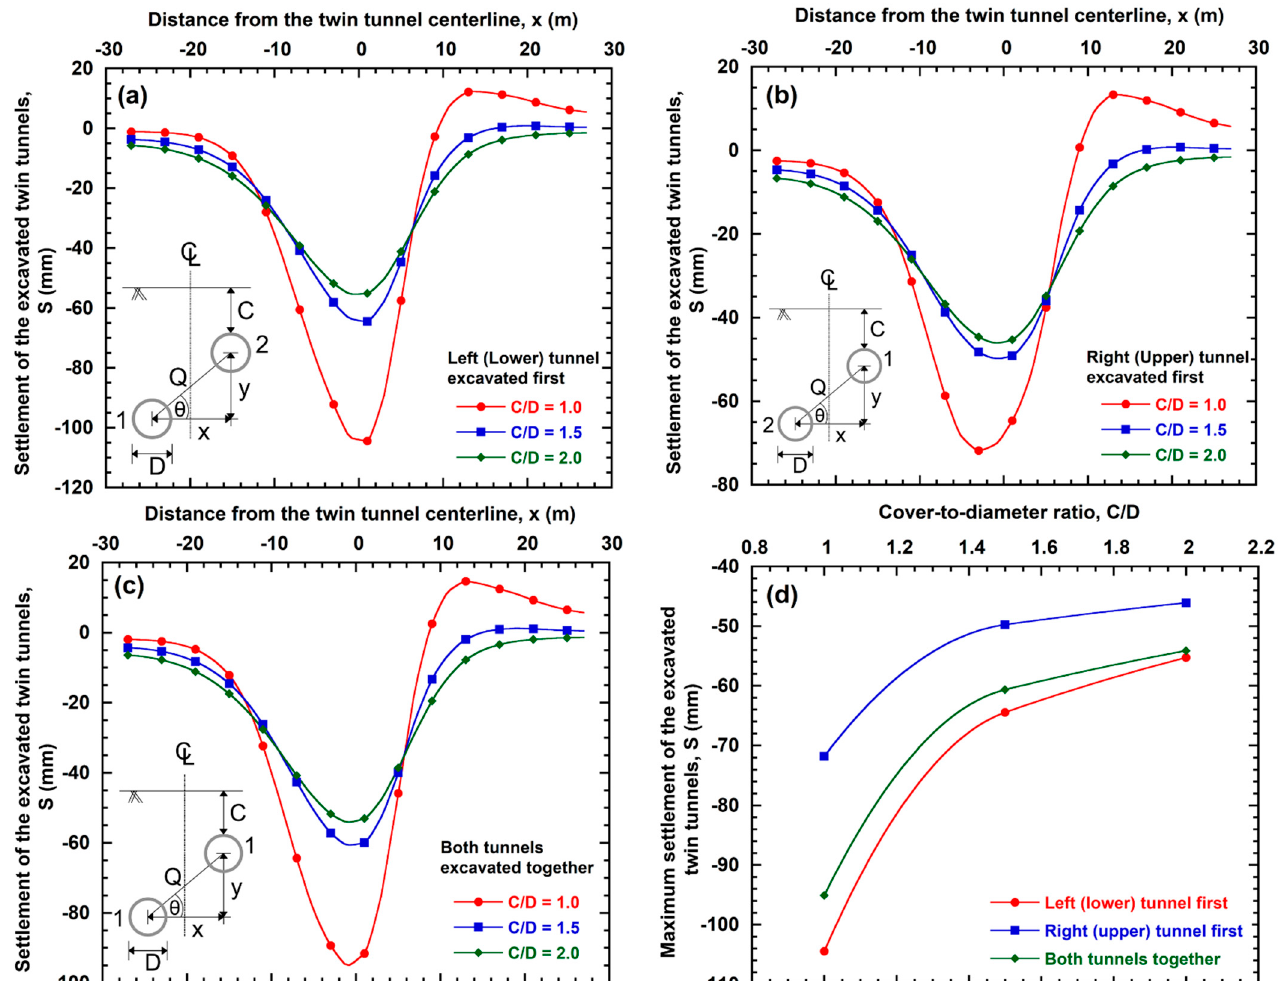
Figure 17. Effect of cover-to-diameter ratio on ( a – c ) combined surface settlement caused by two offset arrangement twin tunnels, and ( d ) maximum total settlement of the excavated twin tunnels.